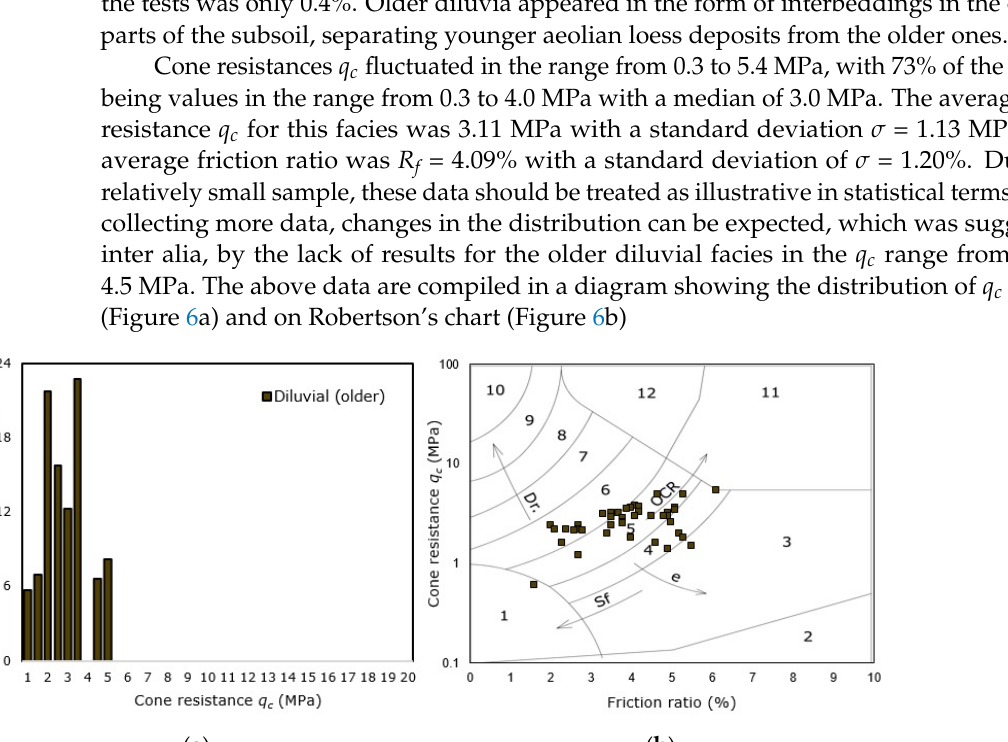
( b ) Figure 7. Summary of results for the alluvial facies: ( a ) distribution of q c values and ( b ) sounding parameters plotted against Robertson’s chart. 3.4. Aeolian Facies—Typical Loess The most numerous sample among the analyzed deposits is the typical loess of the aeolian facies. The total length of the tests within this facies was 6796.9 m, which was 81.0% of the total test run. The results discussed for this facies were therefore most repre-